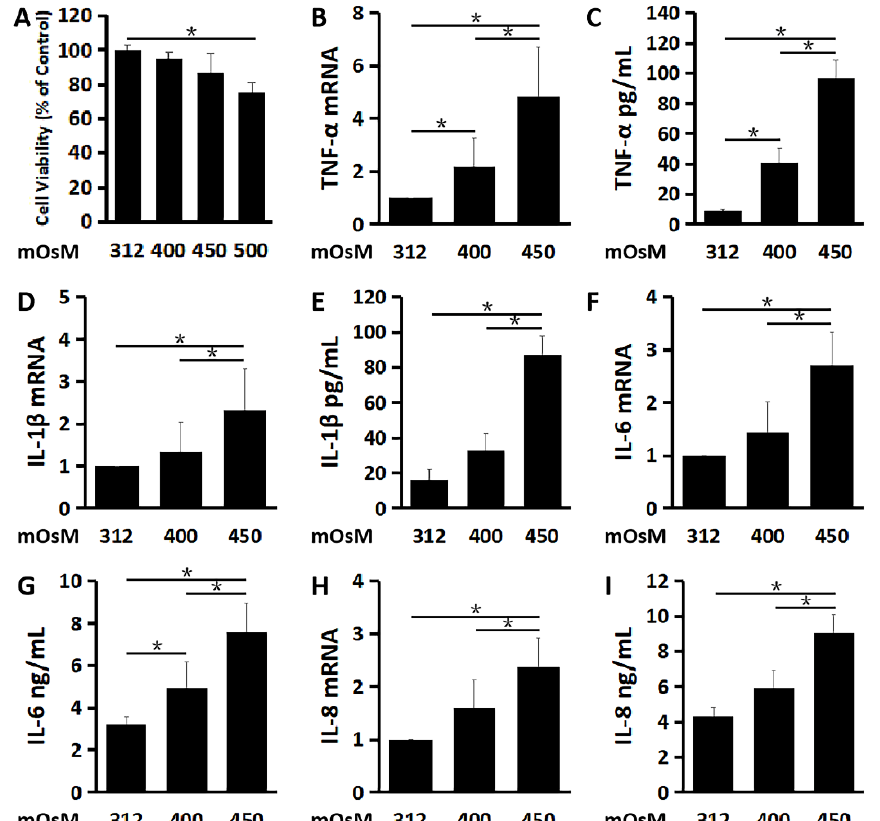
Figure 1. Hyperosmolarity stimulates inflammatory mediators in primary cultured human corneal epithelial cells (HCECs). ( A ) Cell viability of HCECs exposed to different osmolarities analyzed by MTT assay. The pro-inflammatory cytokines, TNF-α ( B and C ), IL-1β ( D and E ) and IL-6 ( F and G ), as well as chemokine IL-8 ( H and I ) significantly increased at mRNA and protein levels in HCECs exposed to a hyperosmolar medium at 400 and 450 mOsM for 4 and 24 h, respectively, compared with isosmolar control at 312 mOsM as evaluated by RT-qPCR and ELISA. Data are presented as mean ± SD of 3 independent experiments. * p < 0.05, compared between two groups.